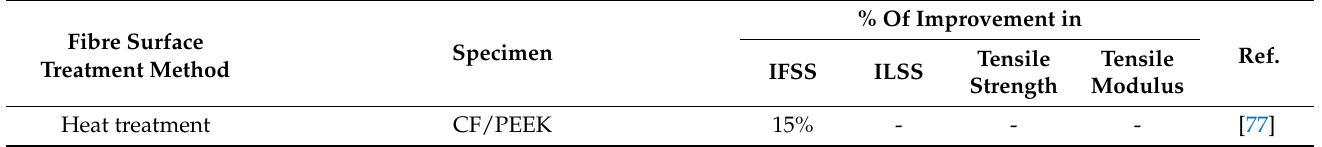
Table 3. Testing results from various fibre surface treatment methods.